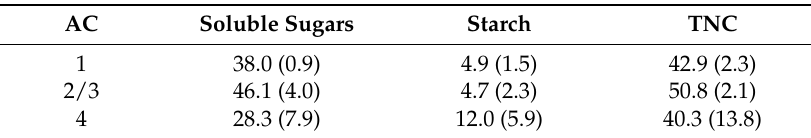
Table 3. Foliar soluble sugar, starch concentrations, and total nonstructural carbohydrates (TNC) (mg/g) between ash canopy condition classes. Values represent mean and (SE). No significant differences across AC classes were observed between soluble sugars, starch, or TNC concentrations were revealed via one-way